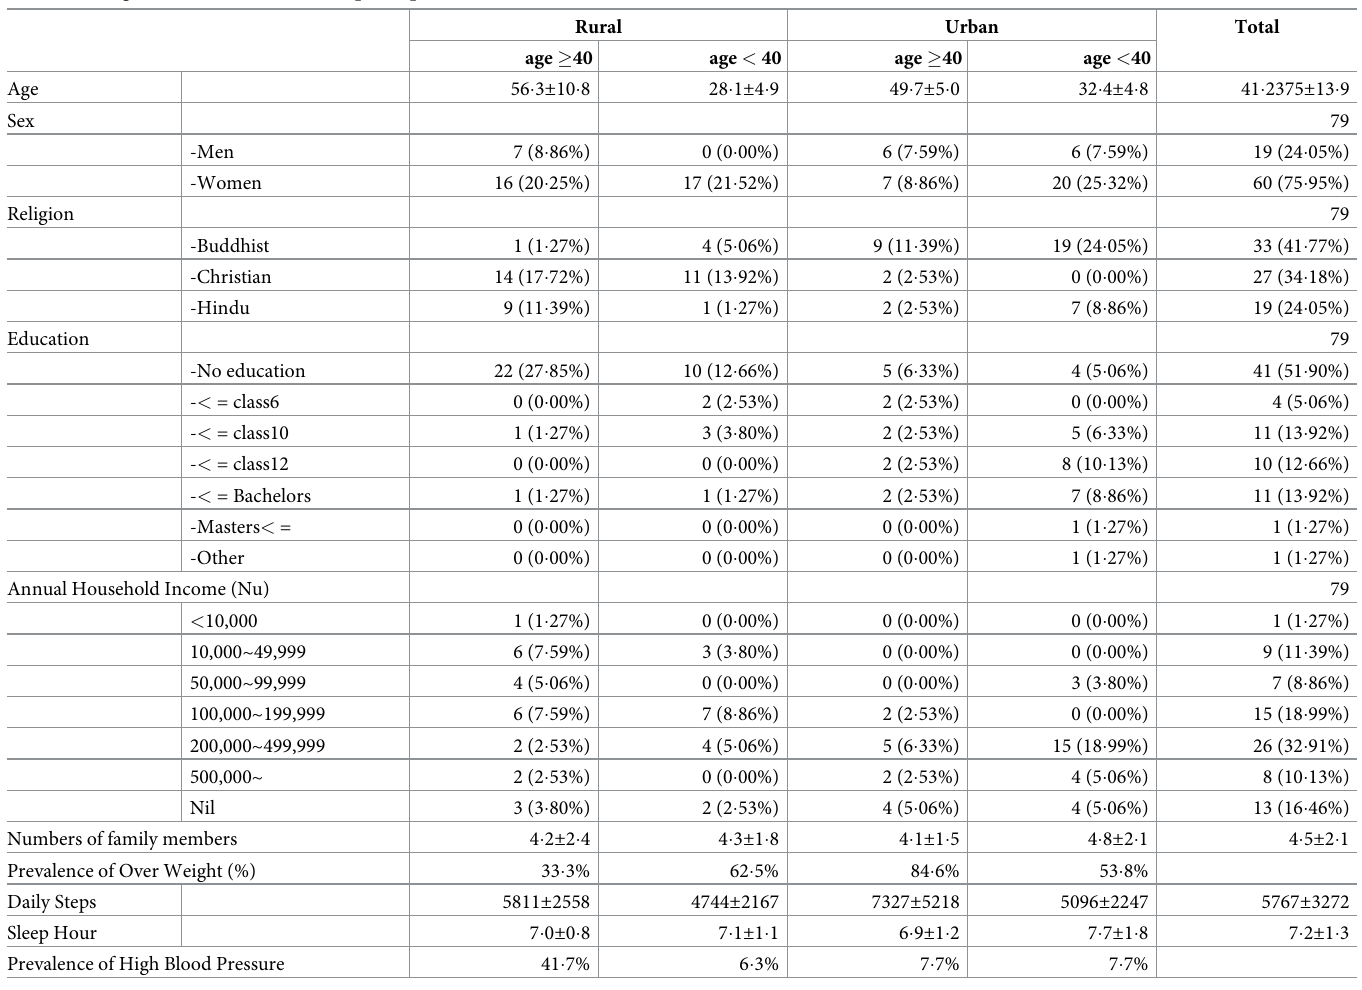
Table 3. Background characteristic of the